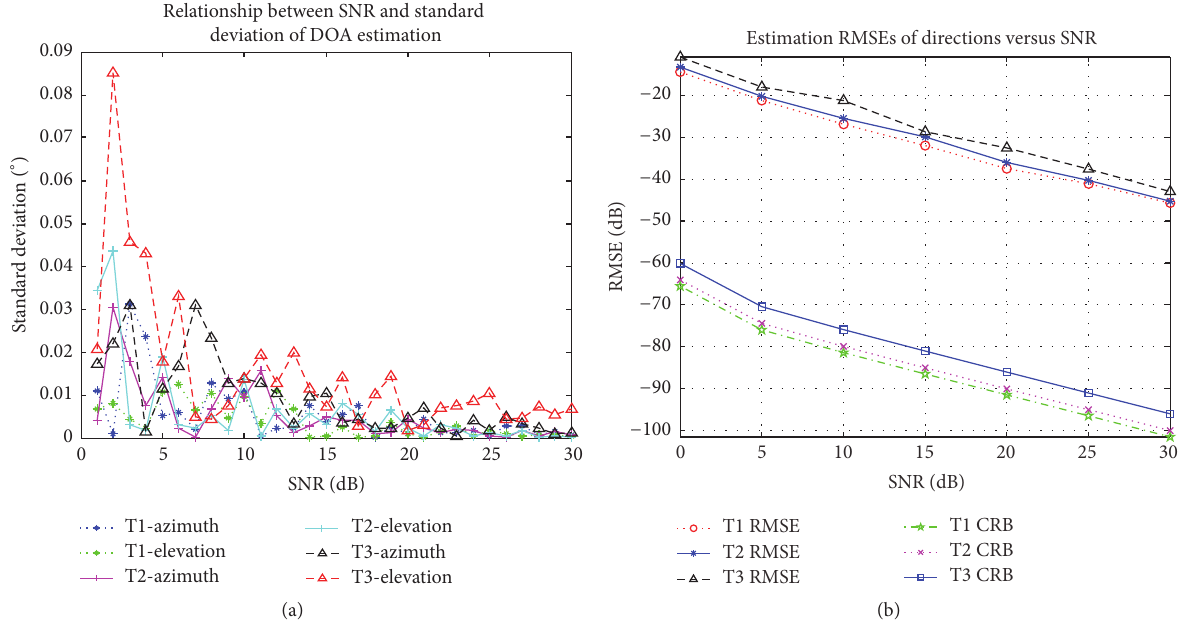
Figure 9: The DOA estimation accuracy with 𝐾 = 200 : (a) deviation of estimates versus SNR and (b) the RMSE and CRB versus SNR.